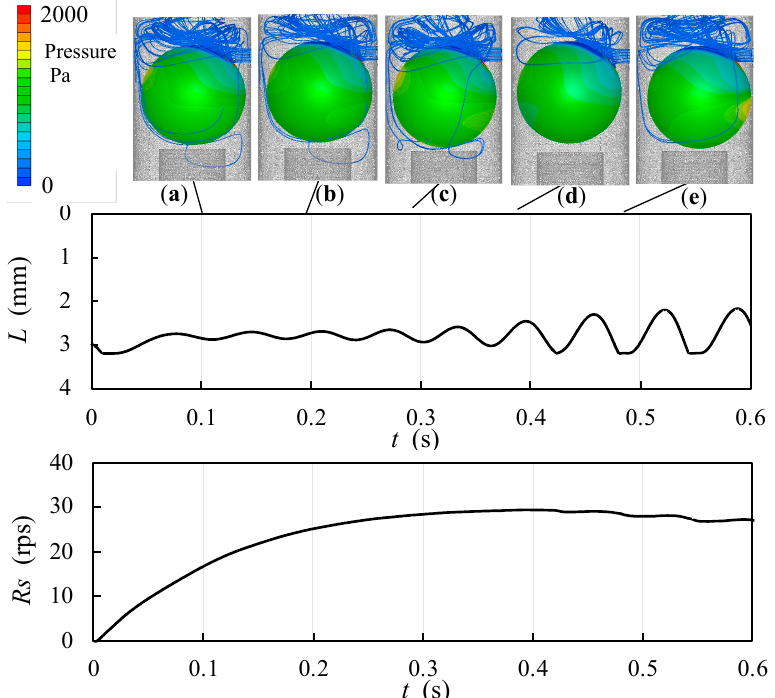
Figure 5. Time variation of lift and rotation speed in high-viscosity case of Model (a): Streamlines and ball surface pressure distribution ( a ) 0.1 s, ( b ) 0.2 s, ( c ) 0.3 s, ( d ) 0.4 s, ( e ) 0.5 s.